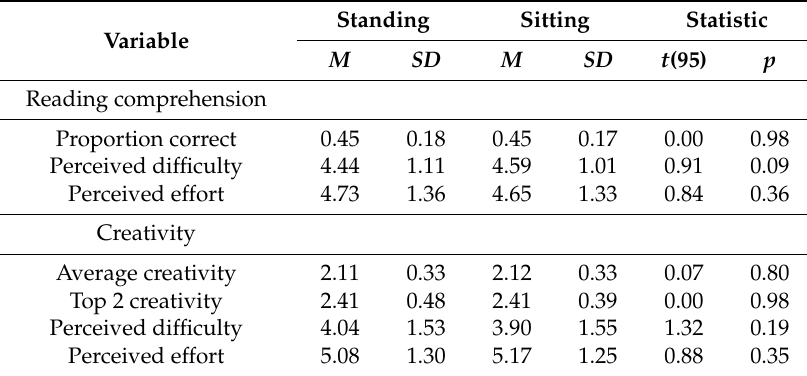
Table 3. Performance and Psychological Outcomes by Position.